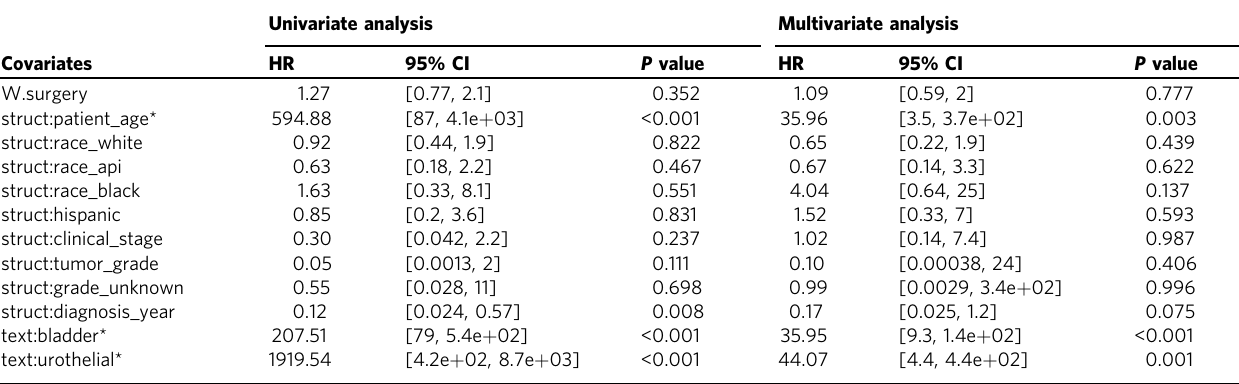
Table 3 Univariate and multivariate covariate-speci fi c HR for surgery vs. radiation for prostate cancer. Univariate analysis Multivariate analysis Covariates HR 95% CI P value